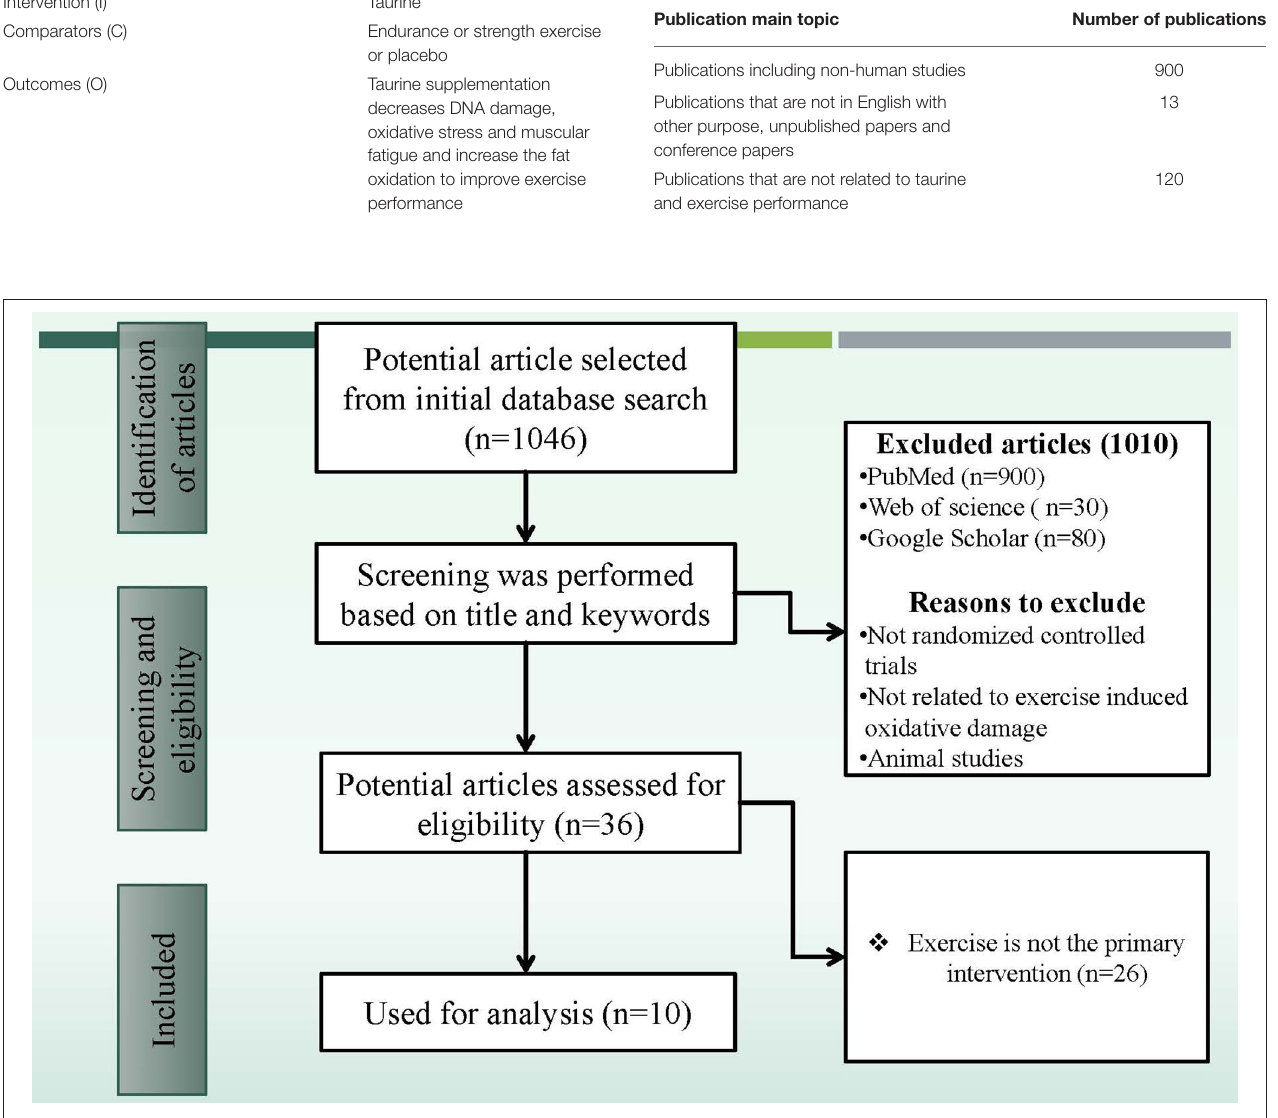
Frontiers in Physiology |